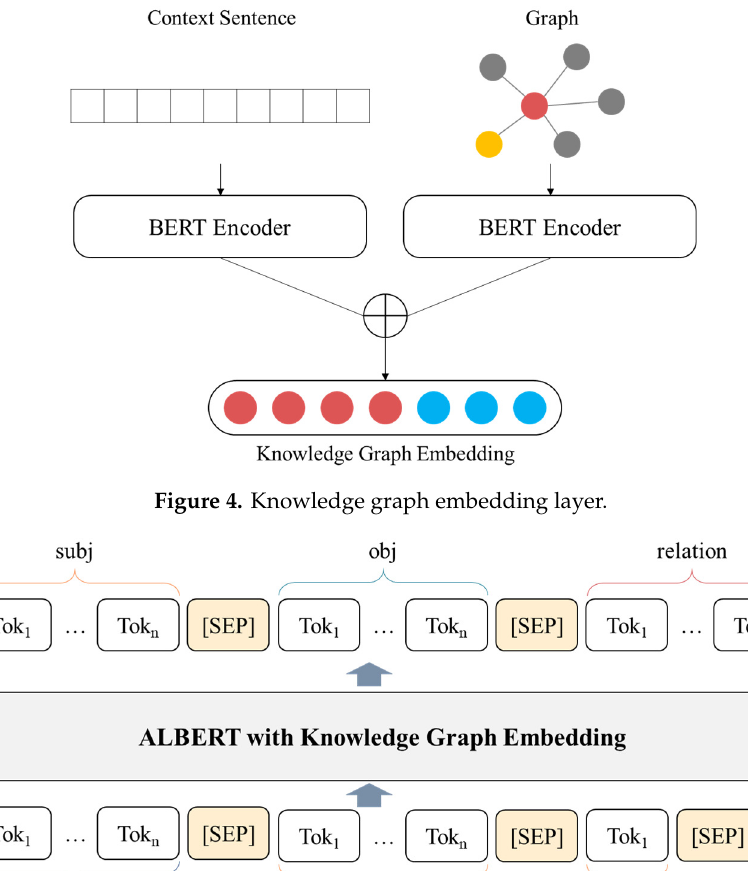
Figure 4. Knowledge graph embedding layer.